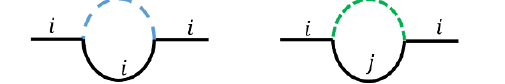
Figure 16. Diagrams contributing to the gamma